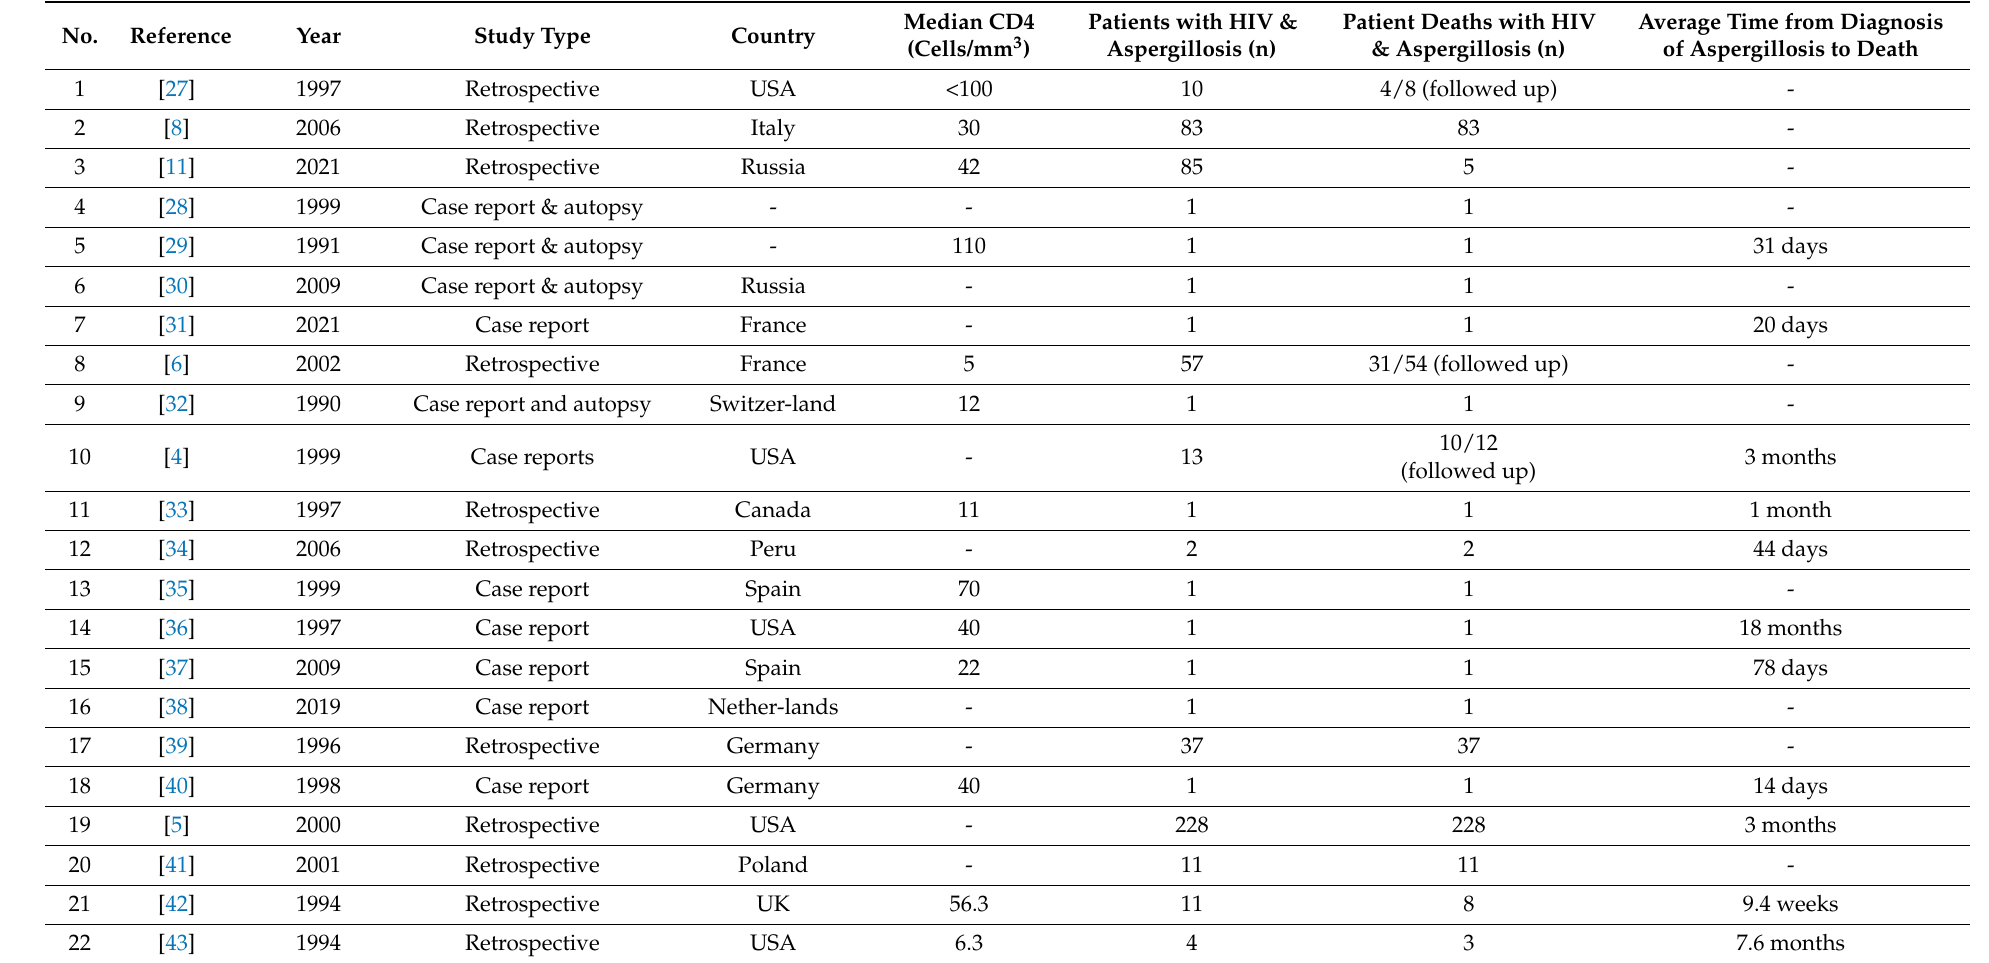
Table 1. Summary of 54 studies of death from aspergillosis and